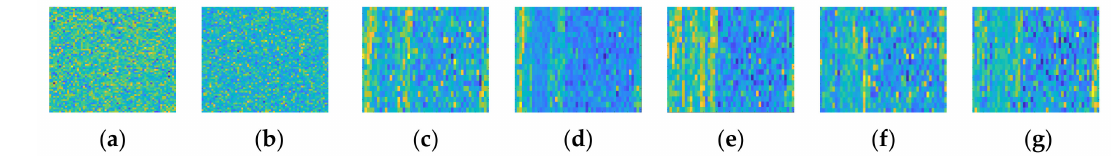
Figure 7. Visualization of different deep feature with the same sample: ( a ) fc6; ( b ) fc7; ( c ) fc8; ( d ) loss3-classifier; ( e ) Fc1000 of ResNet18; ( f ) Fc1000 of ResNet50; ( g ) Fc1000 of ResNet101.